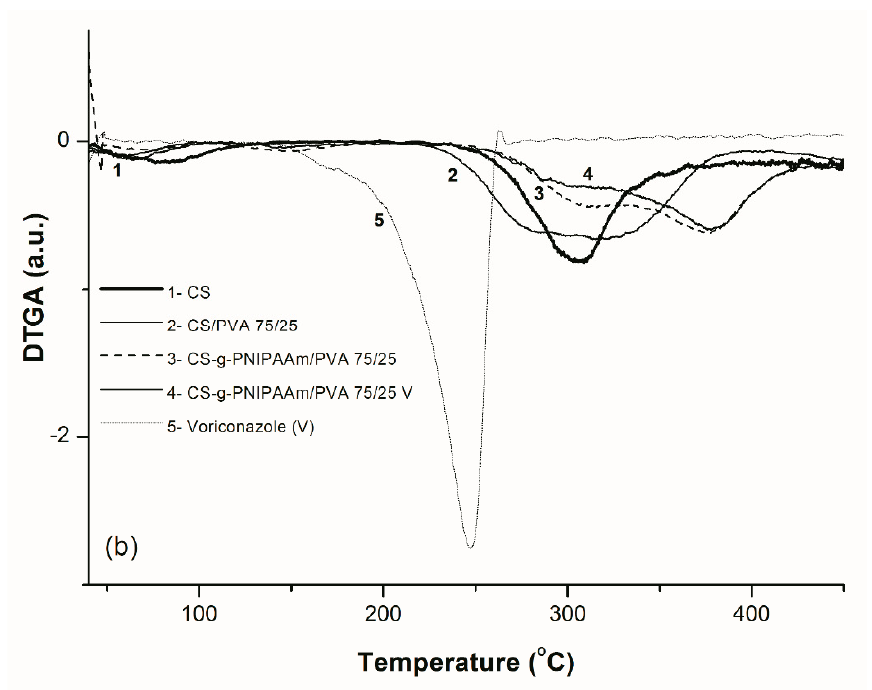
Figure 4. TGA / DTG curves of cryogels based on graft copolymer and pure constituents. ( a ) TG curves and ( b ) first derivative DTG curves.